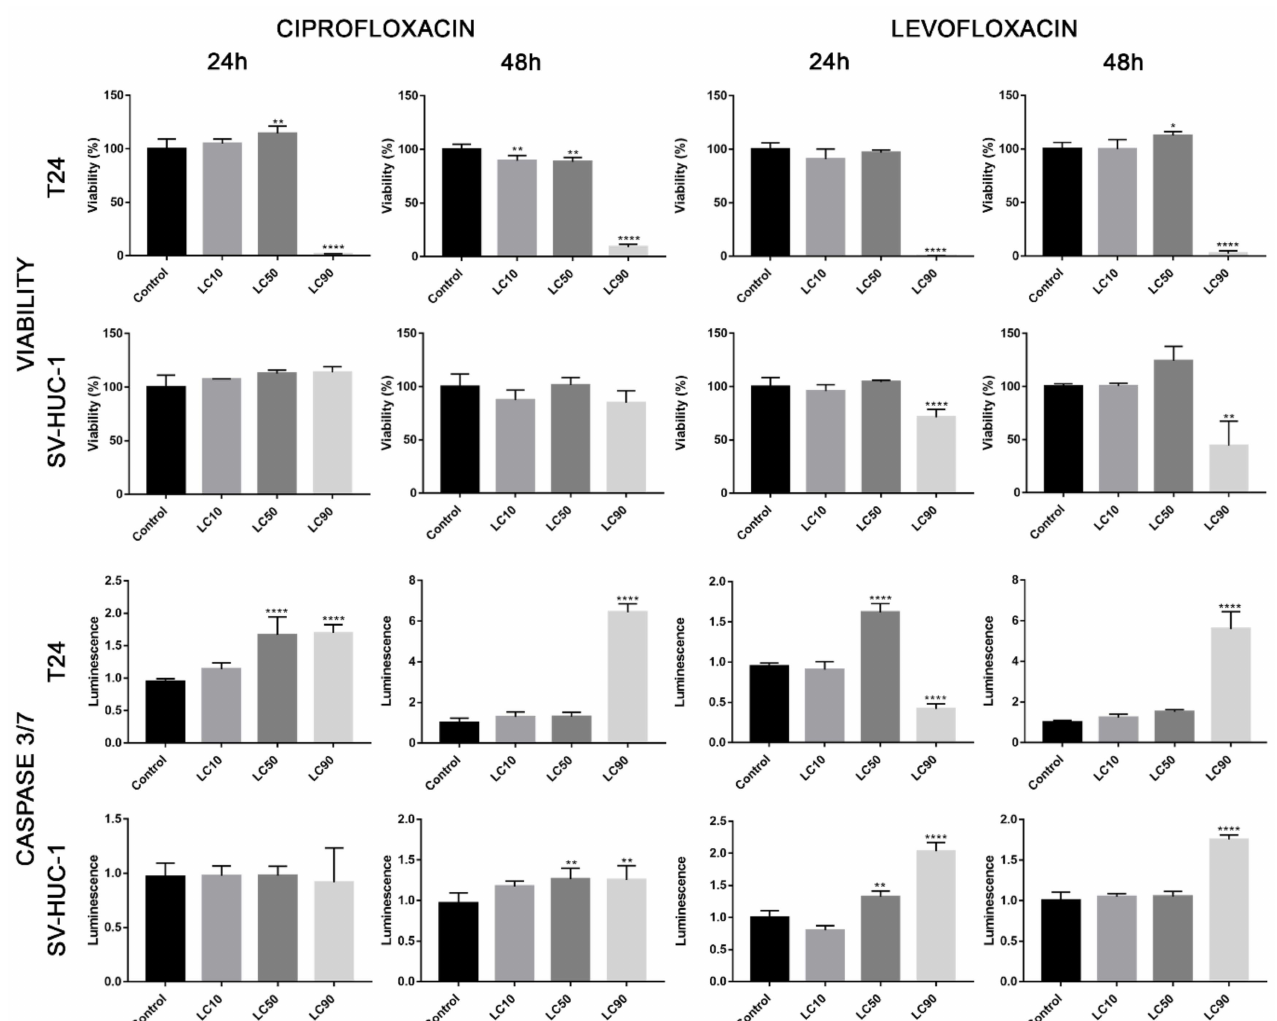
Figure 7. Three-dimensional (3D) cell culture assays following ciprofloxacin and levofloxacin treatment. Analysis of cell viability and activity of caspase 3/7 on spheroids generated from urothelial cell lines. Spheroids were treated by calculated LC concentrations obtained after 24 and 48 h incubation with ciprofloxacin and levofloxacin. Viability was presented as percentage compared to control, luminescence of caspases activity in control was calculated as 1. SV-HUC-1—non- malignant human urothelium; T24—human bladder cancer; DU-145—human prostate cancer; RWPE-1—non-malignant human prostate epithelium, LC—lethal concentration; statistically significant results compared to control were presented: *— p ≤ 0.05; **— p ≤ 0.01; ****— p ≤